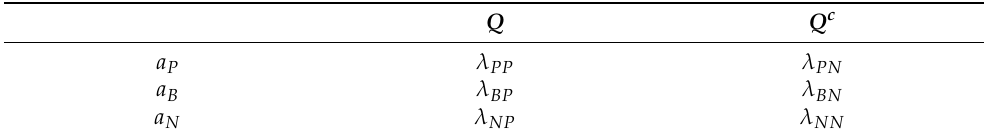
Table 1. The detailed information of a loss function